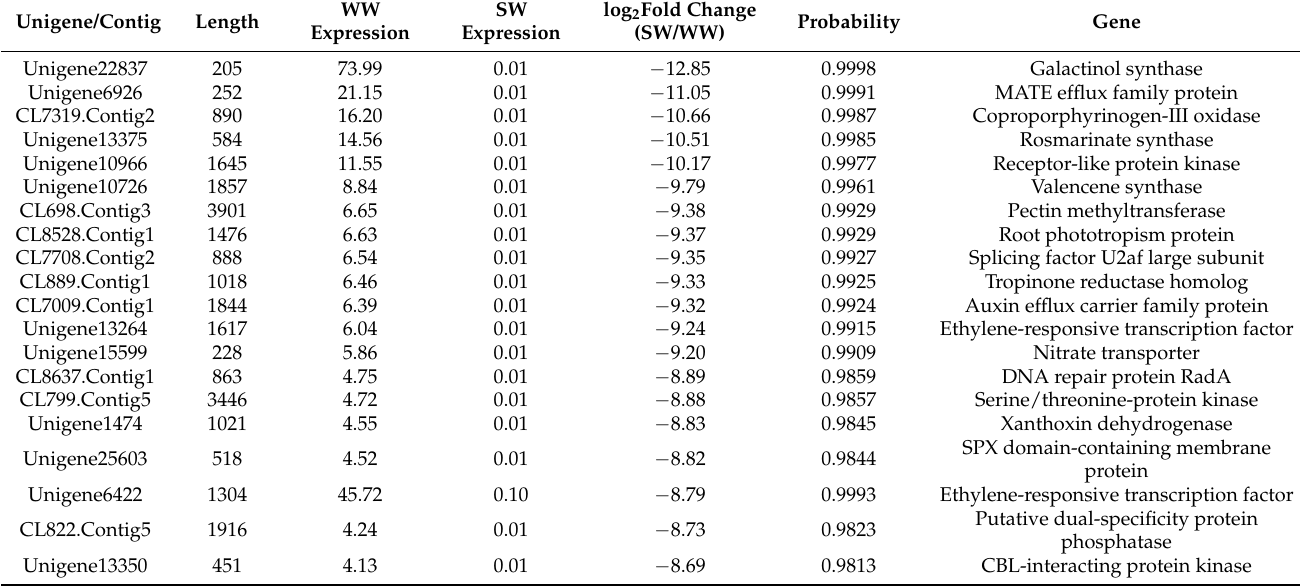
Table 3. List of top 20 downregulated